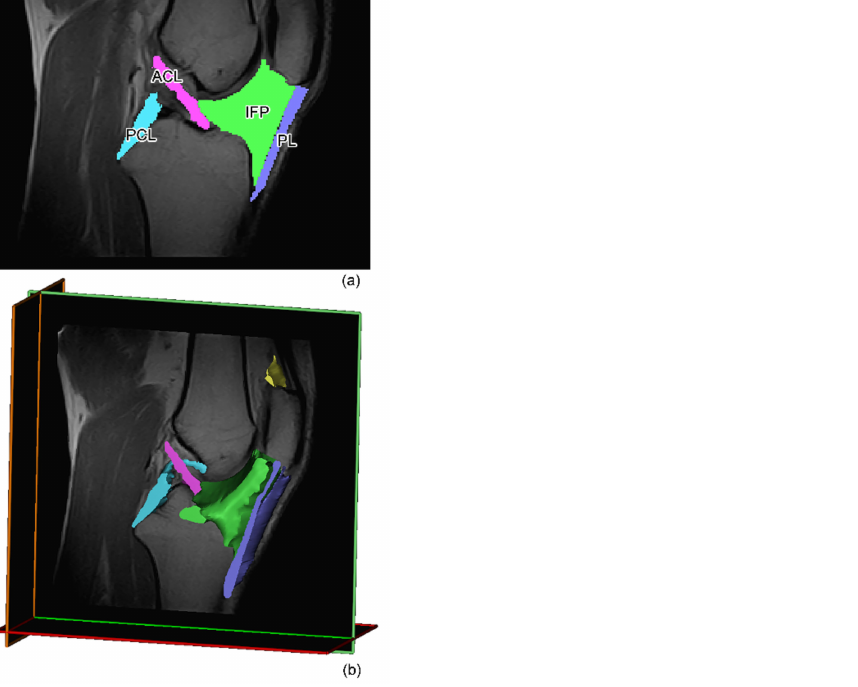
Figure 1. ( a ) IFP (green area), SFP (yellow area), PCL (cyan area), ACL (fuchsia area), and PL (violet area) masks on the central sagittal slice and ( b ) volumes identification on MR of all the tissues analyzed. IFP: infrapatellar fat pad, SFP: suprapatellar fat pad, ACL: anterior cruciate ligament, PCL: posterior cruciate ligament, PL: patellar ligament, MR: magnetic